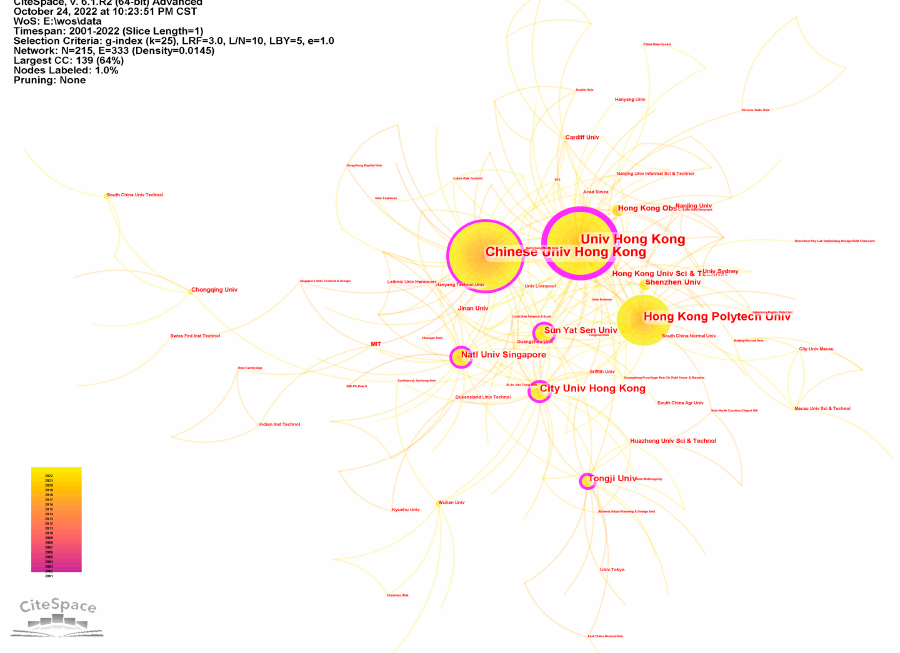
Figure 6. Knowledge map of major institutions in the research field of high-density cities from 2001 to 2022. Table 5. Major institutions in the research field of high-density cities from 2001 to 2022. No.